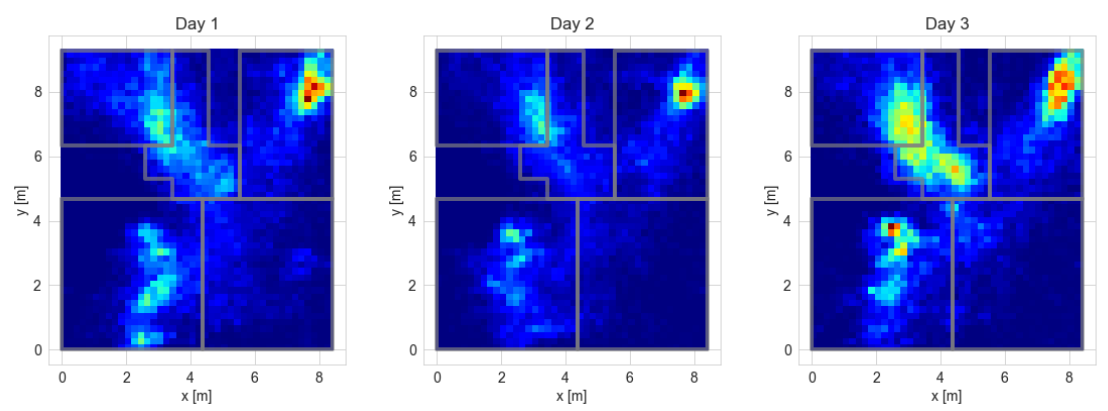
Figure 16. Maps illustrating occupancy of the house areas during three selected days (Day 1–3) of the